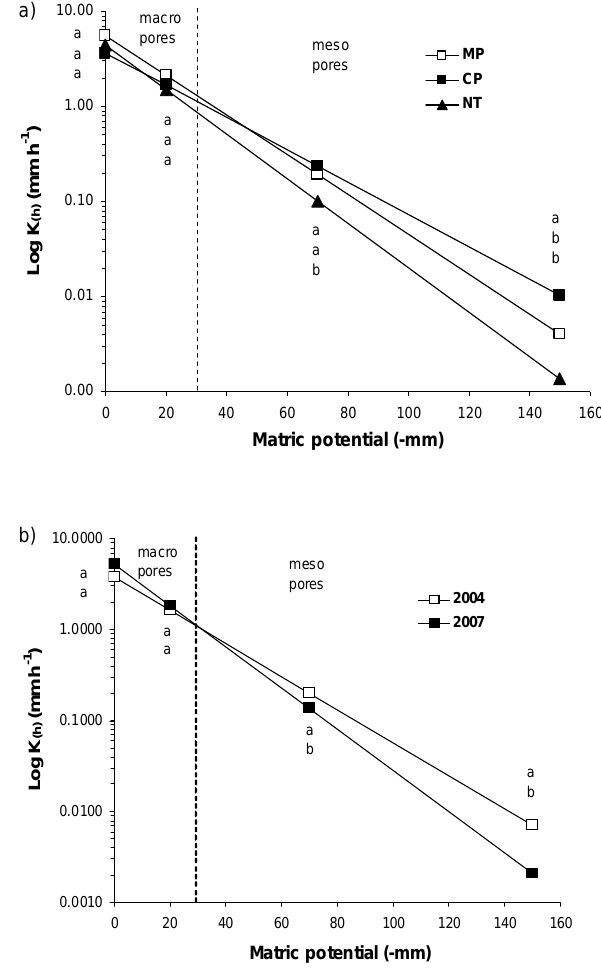
Figure 3. Near-saturated hydraulic conductivity K ( h ) as a func- tion of the matric potential ( h ). (a) of the treatments: moldboard plow (MP), chisel plow (CP) and no tillage (NT) and (b) of the time (years 2004, 2007). Different letters indicate significant differences among treatments ( p